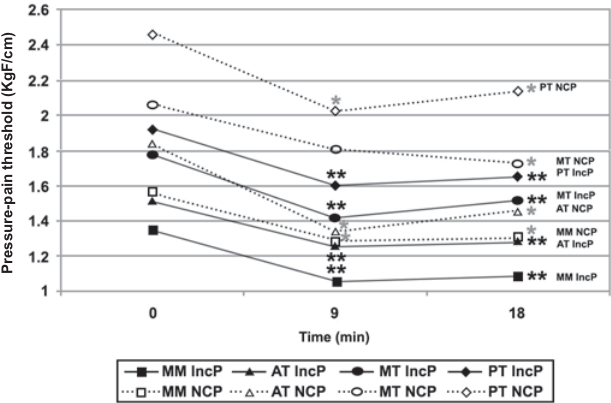
Figure 4- Pressure-pain threshold (PPT) during chewing test [patients with myofascial pain who reported a pain increase (cid:22)%&(cid:30)(cid:8)E(cid:2)(cid:17)(cid:30)(cid:28)(cid:8)G(cid:8)(cid:2)(cid:9)(cid:8)(cid:17)!(cid:11)(cid:2)(cid:20)(cid:6)(cid:8)(cid:14)(cid:2)(cid:8)(cid:23)(cid:11)(cid:14)(cid:2)(cid:8)(cid:22)%&(cid:30)(cid:8)HJ(cid:30)(cid:28)/(cid:26)(cid:8)%%=(cid:12)(cid:3)(cid:23)(cid:6)(cid:7)(cid:21)(cid:17)(cid:14)(cid:11)(cid:18)(cid:8)(cid:4)(cid:11)(cid:12)(cid:12)(cid:6)(cid:13)(cid:6)(cid:7)(cid:8)(cid:5)(cid:9)(cid:16)(cid:19)>(cid:8)%"=(cid:8)(cid:4)(cid:6)(cid:16)(cid:14)(cid:3)(cid:4)(cid:8)(cid:13)(cid:6)(cid:4)(cid:23)(cid:9)(cid:7)(cid:11)(cid:18)(cid:14)(cid:12)>(cid:8)?"=(cid:8)(cid:11)(cid:2)(cid:13)(cid:6)(cid:7)(cid:14)(cid:9)(cid:7)(cid:8) temporalis; PT= posterior